Question: Compose a caption that would accompany this figure in a paper.
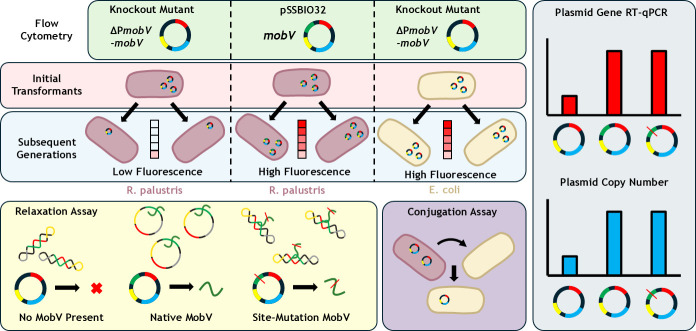
Answer: Summary of results obtained from this study. Flow cytometry was used to determine plasmid retention rates and fluorescence intensity of plasmid-based mRFP. Both relaxation and conjugation functional assays were employed to determine the mechanics of MobV performance in R. palustris . Finally, RT-qPCR was utilized to determine the effects of MobV protein activity on plasmid expression and copy number.